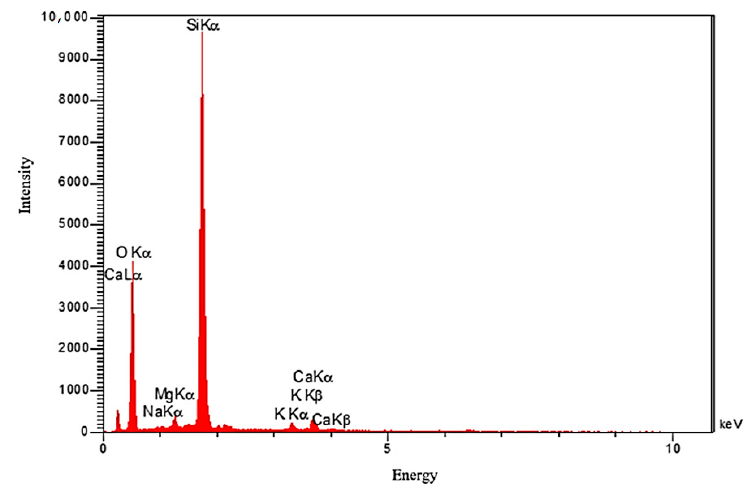
Figure 6. Analysis of EDS.